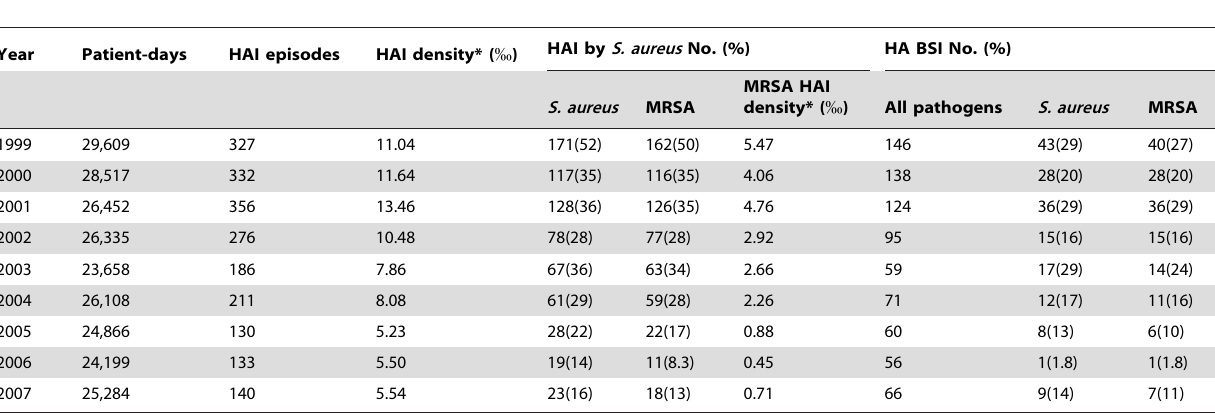
Table 2. Healthcare-associated infections (HAIs) in the neonatal intensive care units of Chang Gung Children’s Hospital between 1999 and